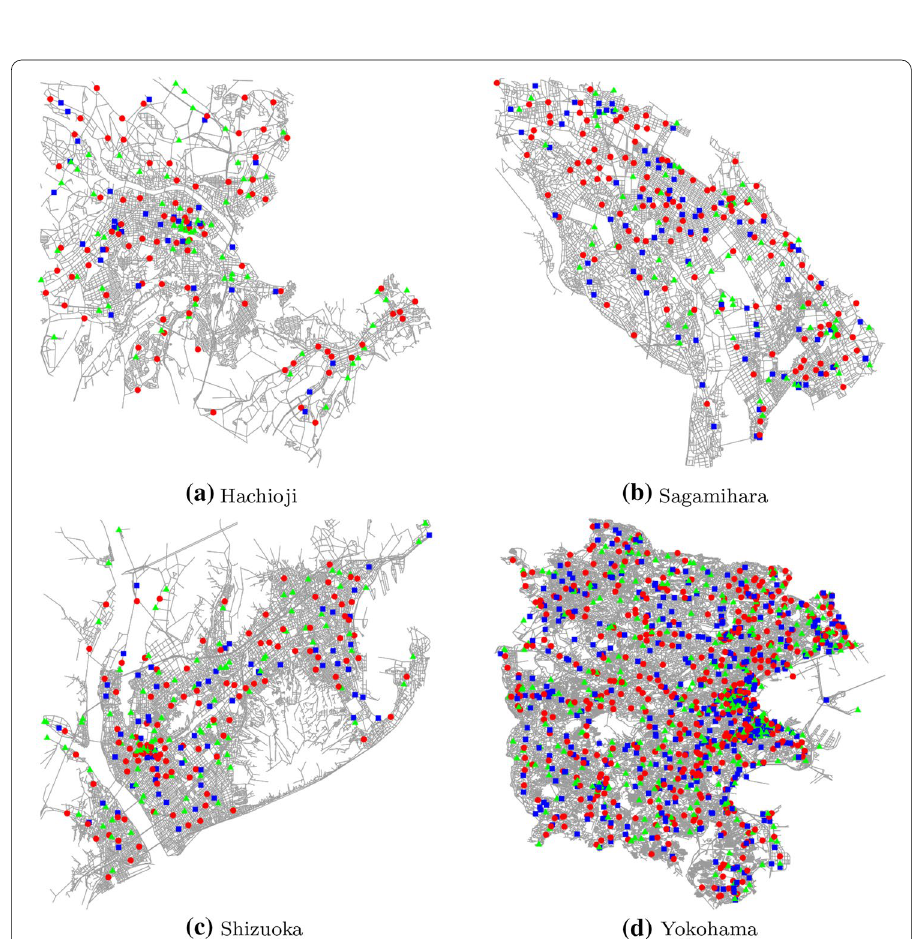
Fig. 2 Visualization results with actual locations of convenience stores: The red, green, and blue markers represent store nodes of g1, g2, and g3,